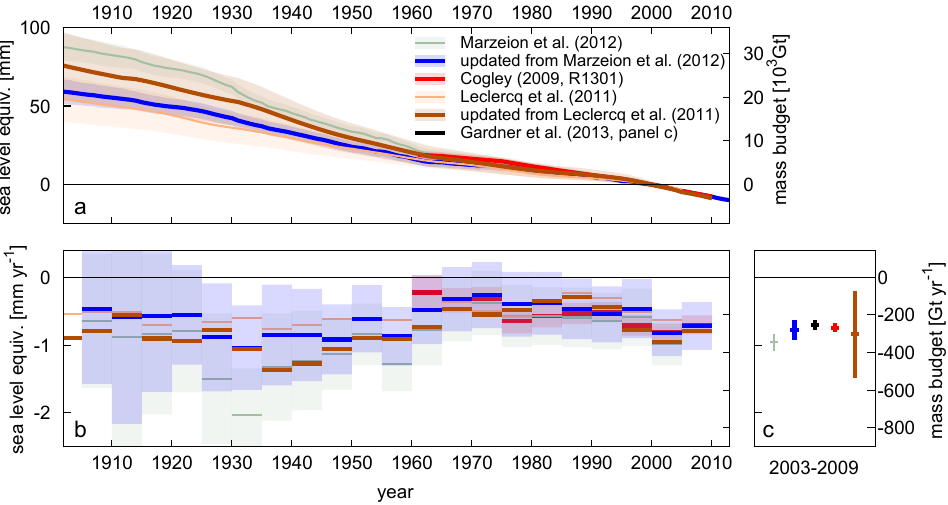
Figure 1. Globally integrated glacier mass change: (a) accumulated in time, relative to the year 2000; (b) 5-year mean values of mass change rates; (c) mean mass change rates during 2003 to 2009. Shading and error bars indicate 90% confidence interval. Note that all reconstructions exclude glaciers in the Antarctic